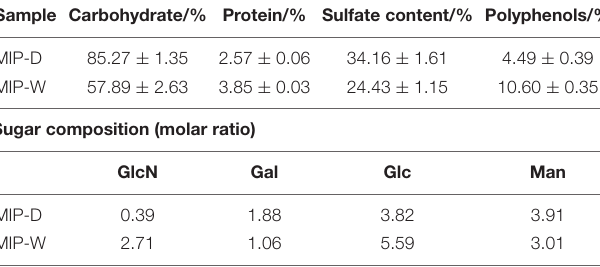
TABLE 1 | Chemical composition and sugar composition of